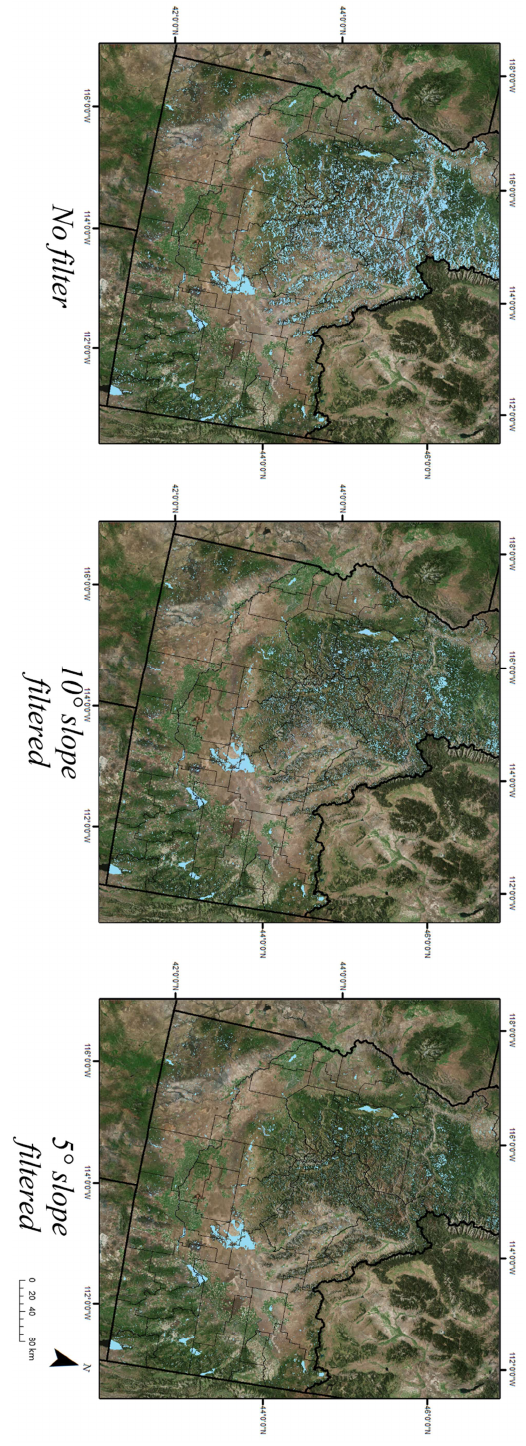
Figure 7. Water surface and filtered false classification by 30 m slope in southeastern Idaho.